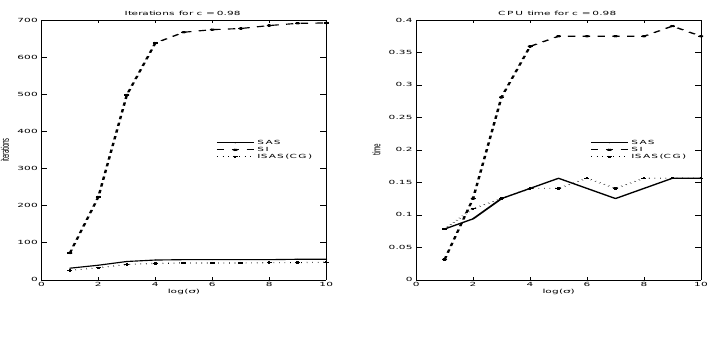
Figure 2. Comparison at fixed c=0.99 of Source Iteration, SAS and ISAS(CG) in slab geometry ( ǫ = 1 E − 06 ): (left) Number of iterations; (right) CPU time.